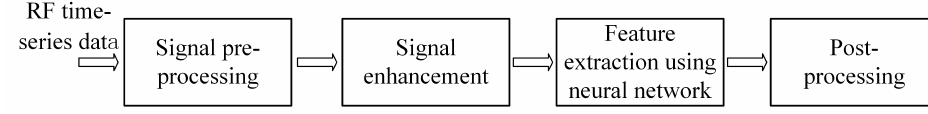
Figure 2. The proposed framework for multi-signal